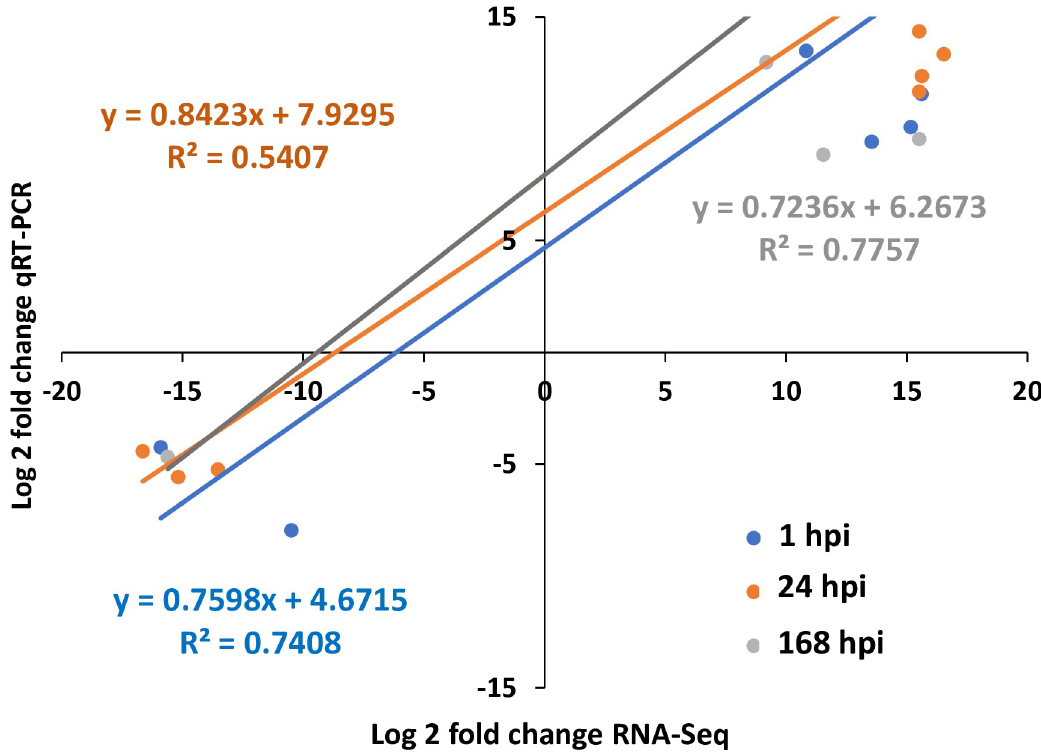
Fig 3. qRT–PCR validation of DEGs obtained from RNA-Seq sequencing of potato tubers inoculated with D . solani . Trend lines of qRT–PCR validation of time-course RNA-Seq, RNA-Seq data (x-axis) and qRT–PCR (y-axis) data (log2 fold change) analyzed by the Pearson test (p < 0.05). The trend line equation and the corresponding square regression coefficient (R2) are shown. The statistical analysis for the data was performed with coefficient correlation analysis between RNA-Seq and qRT–PCR data (log2 fold change) analyzed by the Pearson test (p < 0.05), which resulted in a strong correlation between the analysis methods. Bar graphs of the individual genes are shown in S1 Fig, primer sequences and full names of the genes are shown in S4 Table, and the primary qRT–PCR data are shown in S5